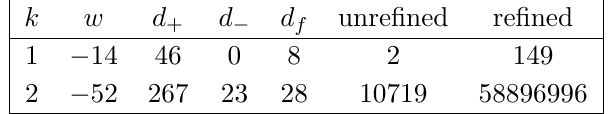
d 4 in terms of D ( b 4 )